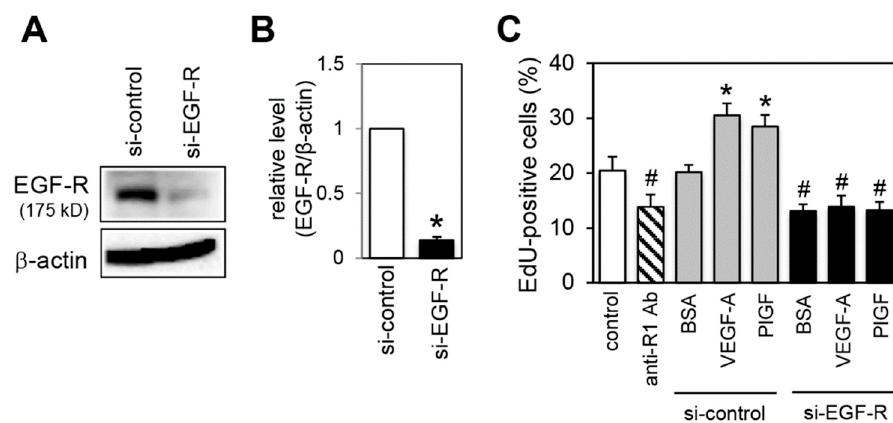
Figure 7. EGF-R knockdown blocks VEGFR-1 activation-induced proliferation activity. ( A ) Cells were transfected with the indicated siRNA for 24 h. EGF-R protein levels were determined by immunoblot analysis. The levels of β -actin are shown as a loading control. ( B ) Quantification of EGF-R levels normalized to β -actin from three independent experiments. * p < 0.01, statistically significant decrease compared with the si-control-treated cells. ( C ) Quantification of EdU positive cells under EGF-R silencing conditions. Cells were transfected with the indicated siRNA for 24 h, then treated with VEGF-A, PlGF or BSA for the additional 24 h. For a control experiment, cells were treated with only anti-R1 Ab or control IgG (indicated by control) for 24 h. Data are indicated by means ± SD ( n = 6–8). # p < 0.01, statistically significant decrease compared with the control. * p < 0.01, statistically significant increase compared with the control.